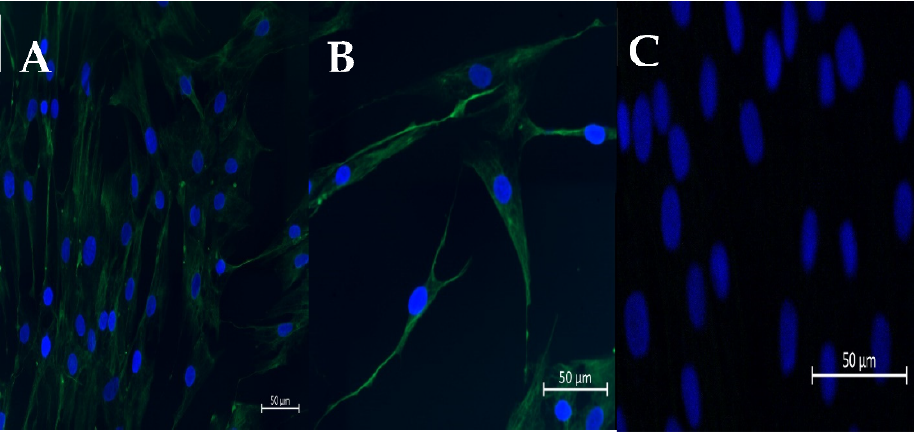
Figure 1. Representative pictures of immunofluorescence staining of vimentin ( A , B ) in cultured fibroblasts. ( C ) DAPI staining. Scale bar = 50 μ m (magnification: 20,40).